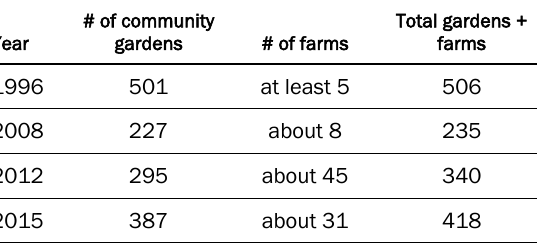
Table 1. Community Gardens and Farms Growing Food in